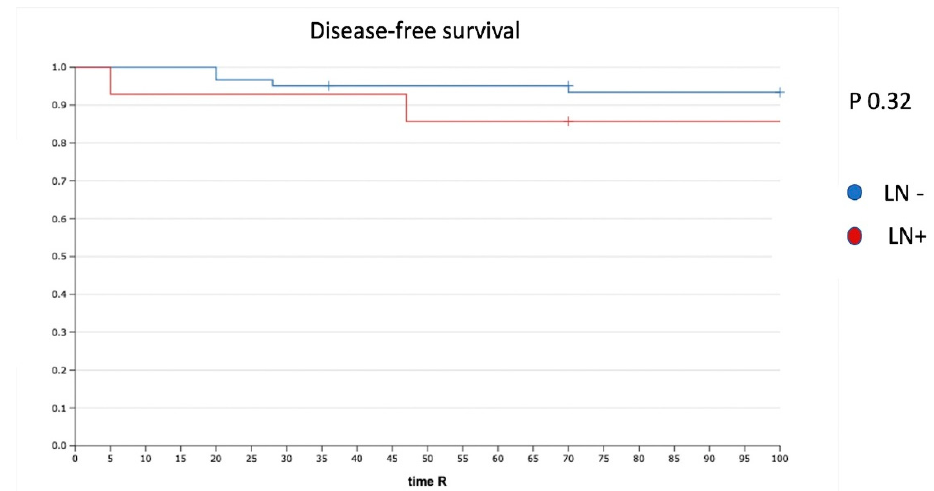
Figure 2. DFS in patients with positive and negative LN. LN − : negative lymph node; LN+: positive lymph node.